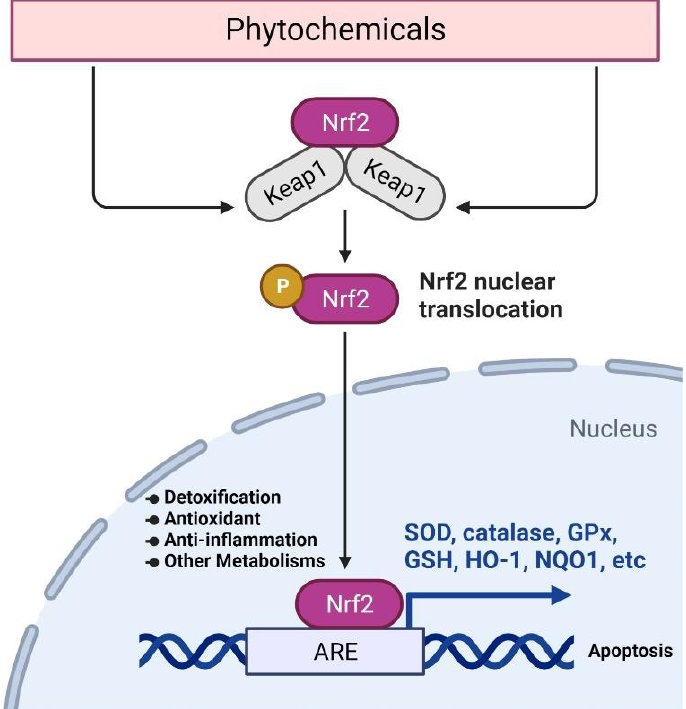
Figure 2. General mechanism of Nrf2-mediated expression of various detoxification and antioxidant enzymes by potential chemoprevention agents such as phytochemicals.